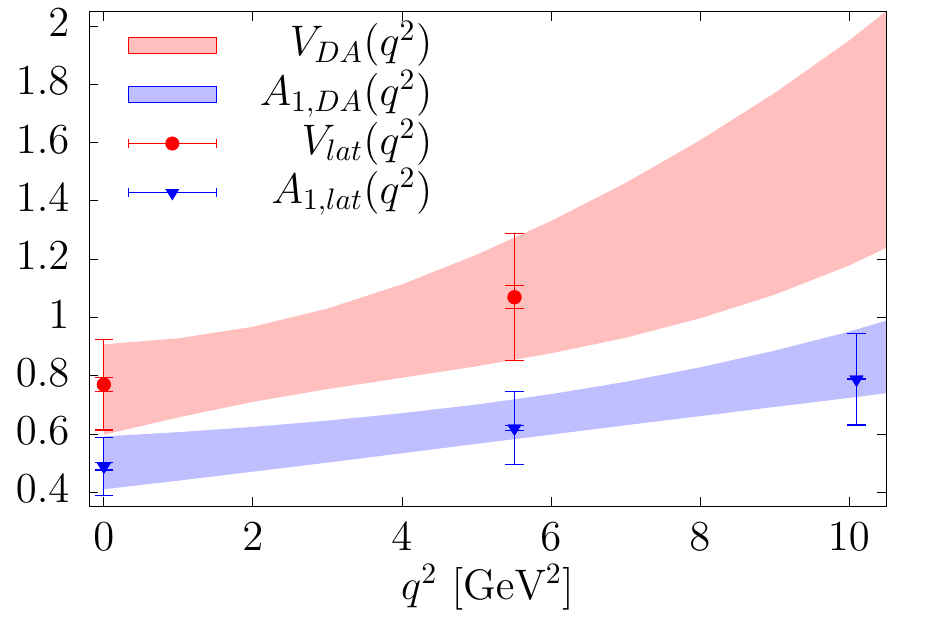
Figure 2 . B + → J/ψ form factors V ( q 2 ) (red circles) and A 1 ( q 2 ) (blue triangles) from the HPQCD c Collaboration [33, 34]. The interior bars represent the statistical uncertainty quoted by HPQCD. The exterior bars represent the result of including our f lat =20% systematic uncertainty. The colored bands DA (dispersive analysis) represent our one-standard-deviation (1 σ ) best-fit region.